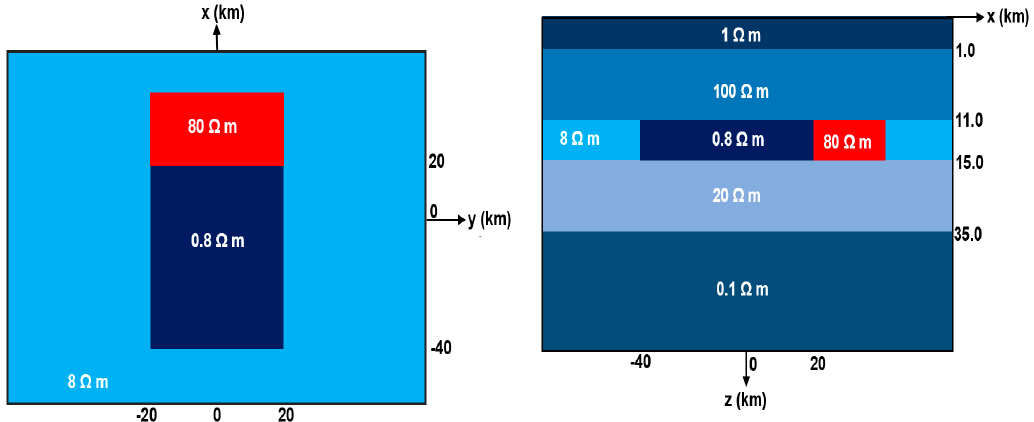
Figure 9. The planar and vertical cross-section view of the model 3. The anomalous bodies are embedded in the middle homogenous layer.